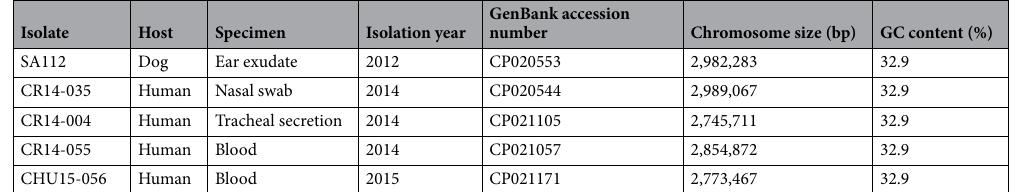
Table 2. Characteristics of the completely closed genomes from ST5 MRSA strains sequenced in this study. The strain SA112 is from canine origin and all others from humans. Information about genome assembly and BioProject can be obtained by accessing the